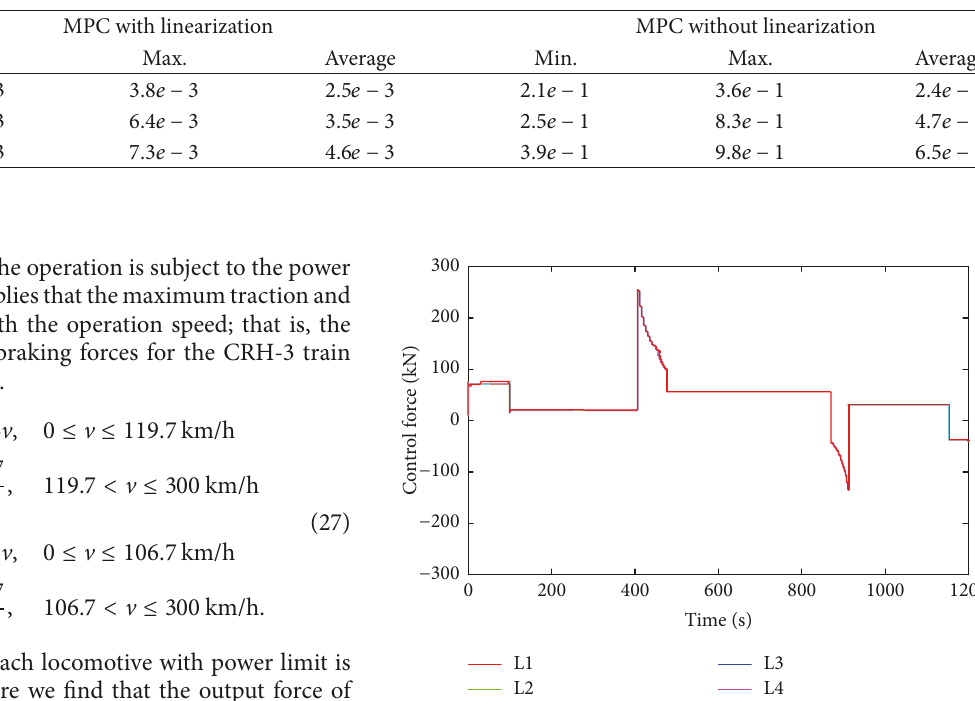
Figure 12: The force output of each locomotive with power